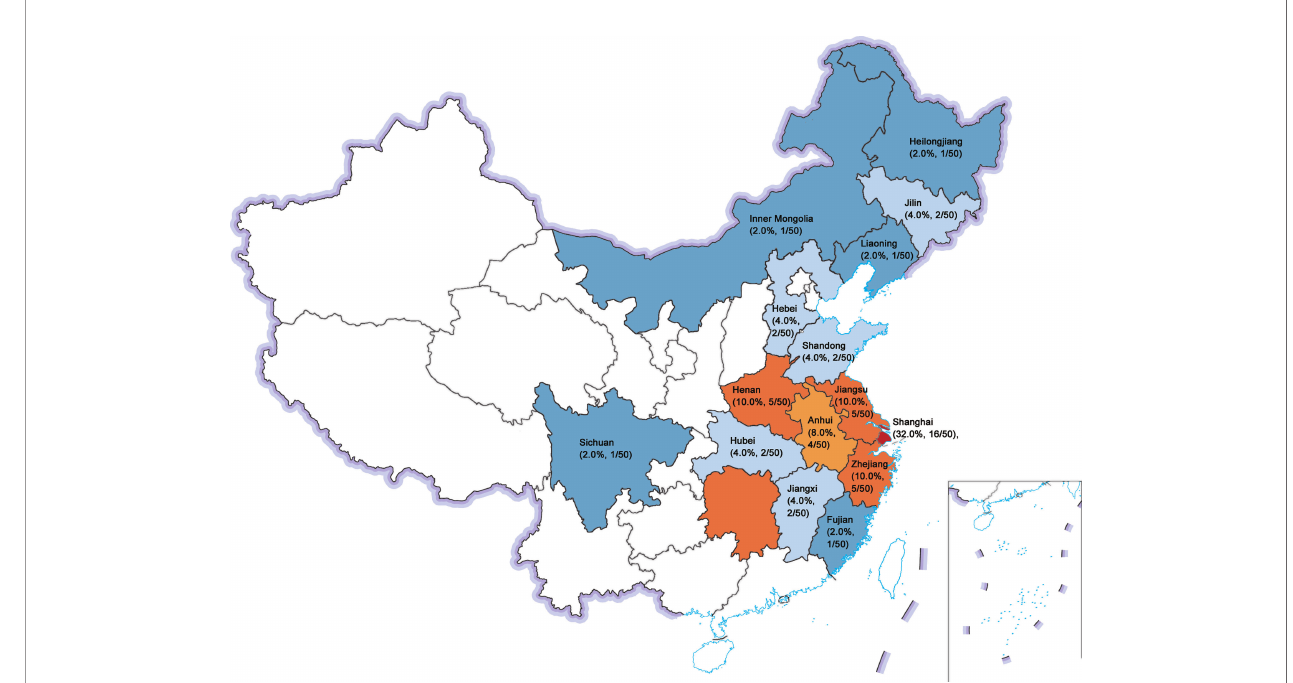
FIGURE 1 | Geographical provenance of the sporadic PDB patients in Chinese population. The fi gure reported as region (composition ratio, number of patients): Shanghai (32.0%, 16/50), Jiangsu (10.0%, 5/50), Henan (10.0%, 5/50), Zhejiang (10.0%, 5/50), Anhui (8.0%, 4/50), Hubei (4.0%, 2/50), Jilin (4.0%, 2/50), Hebei (4.0%, 2/50), Shandong (4.0%, 2/50), Jiangxi (4.0%, 2/50), Fujian (2.0%, 1/50), Liaoning (2.0%, 1/50), Inner Mongolia (2.0%, 1/50), Sichuan (2.0%, 1/50), and Heilongjiang (2.0%,